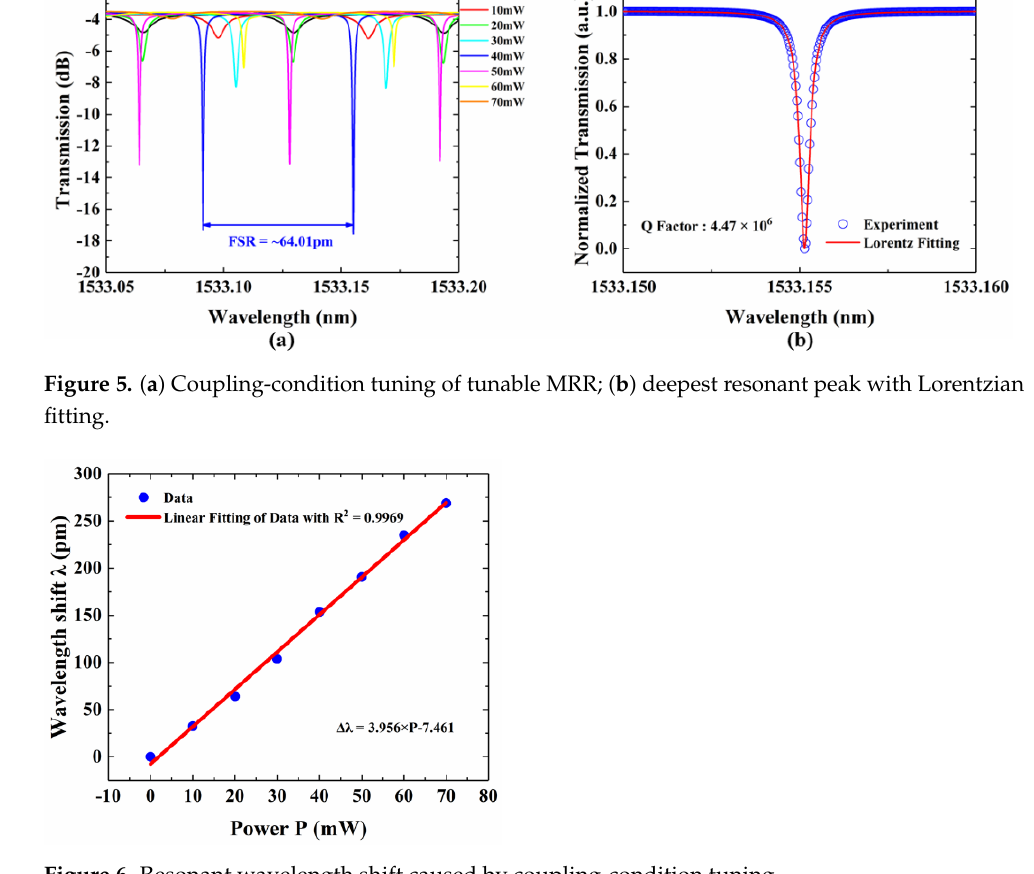
Figure 6. Resonant wavelength shift caused by coupling-condition tuning.